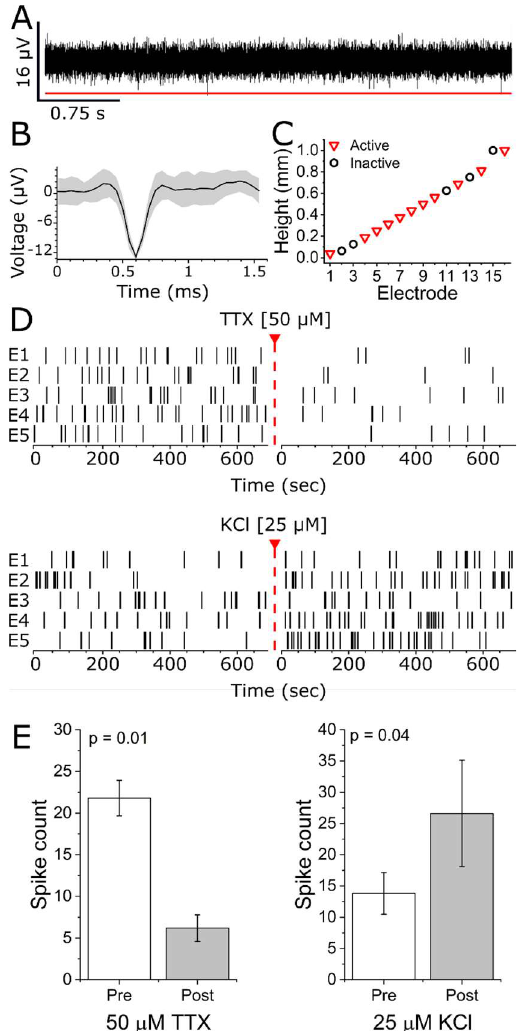
Figure 4. Spontaneous EAP recordings from iPSC sensory neurons on 3D helical MEAs. ( A ) Representative voltage versus time trace for a single electrode recorded at 20 kHz. Red line indicates 4.5 σ threshold for detection of EAPs. ( B ) Representative traces of characteristic waveform collections (i.e., single units). The black line indicates the waveform average and the grey region the standard deviation. ( C ) Active electrode yield height distribution for a single helical array. Downward red triangle indicates electrode numbers/heights that recorded single units. Black circles indicate inactive electrodes. Heights are estimated based on pre-seeded configuration. ( D ) Representative raster plots from five electrodes on a single MEA exhibiting spontaneous activity (left) and 50 µM TTX-inhibited (top right) or 25 µM KCl-evoked (bottom right) recordings. The red triangle and dashed line indicate compound addition. Recordings were resumed as soon as possible following com- pound addition (<1 min). ( E ) Quantification and statistical analysis of TTX (left) and KCl (right)